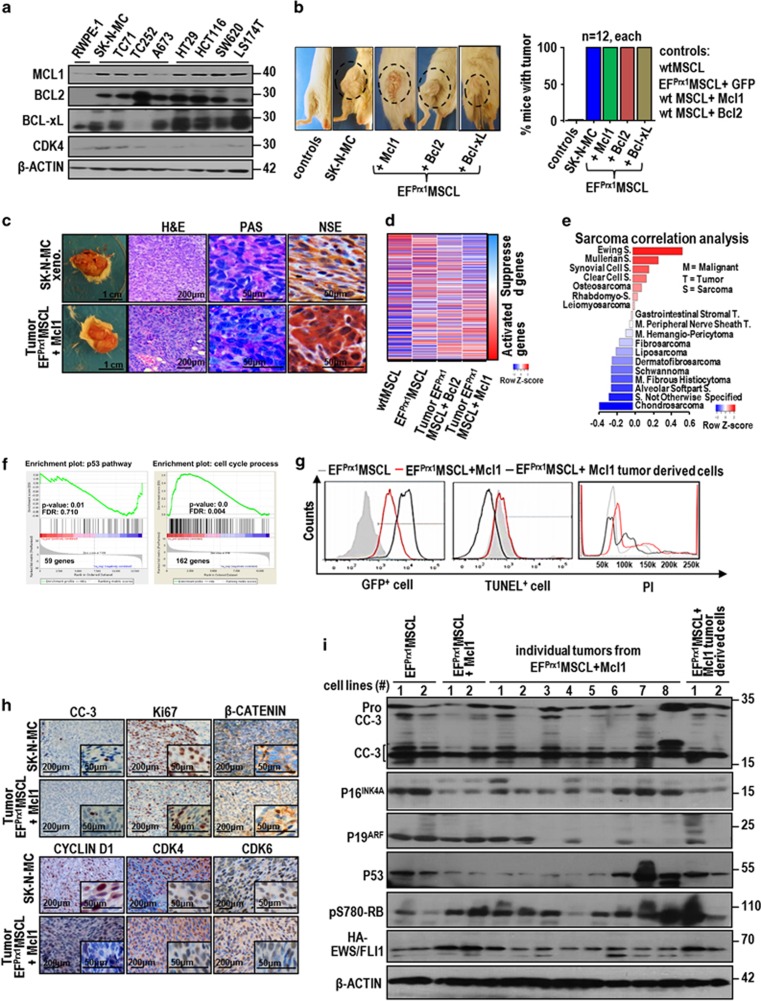
EFPrx1MSCL give rise to sarcomas upon enhanced expression of anti-apoptotic BCL2 family members. (a) ES cell lines SK-N-MC, TC71, TC252 and A673 expressed prominent level of MCL1, BCL2 and BCL-xL. Colorectal carcinoma cell lines HT29, HCT116, SW620 and LS174T were used as positive control. CDK4 expression was higher than in the control human prostate epithelial cell line RWPE-1. (b) Four different EFPrx1MSCL and four different wtMSCL were transduced by retrovirus with either GFP-vector, Bcl2-IRES-eGFP, Bcl-xL-IRES-eGFP or Mcl1-IRES-eGFP. A total of 12 primary cell transductions for each cell line were xenografted (n=12, each). All Bcl2, Bcl-xL and Mcl1-expressing EFPrx1MSCL lines formed reproducibly sarcomas with full penetration as quantified in the right graph. None of the controls like the wtMSCL with or without BCL2 family member transduction or GFP-transduced EFPrx1MSCL formed any sarcoma up to 6 months post transplant. (c) Xenografted sarcomas were positive for periodic acid schiff (PAS) and neuronal-specific enolase (NSE) staining. SK-N-MC xenograft served as positive control. (d) RNA-seq analysis (from left to right) of wtMSCL, EFPrx1MSCL, two sarcoma samples from EFPrx1MSCL+Bcl2 and EFPrx1MSCL+Mcl1 revealed that samples become more similar to the ES gene expression signature (Kauer data set28). (e) Clustering analysis showed the best matching of EFPrx1MSCL+Mcl1 tumor genes to human ES signatures. (f) Gene enrichment analysis (GSEA) exhibited a noticeable upregulation of cell cycle and a downregulation of p53 pathway in mouse EFPrx1MSCL+Mcl1 tumors versus wtMSCL. (g) EFPrx1MSCL at passage 30 served as controls. Two representative sarcoma lines EFPrx1MSCL+Mcl1 were established each that displayed an increase of GFP expression and a decrease in TUNEL+ cells after sarcomas formed, whereas PI staining displayed more proliferation in EFPrx1MSCL+Mcl1 and EFPrx1MSCL+Mcl1 tumor-derived cells. (h) Proliferative sarcoma cells were also positive for nuclear β-catenin, cyclin D1, CDK6 and CDK4, whereas cleaved caspase-3 (CC-3) was downregulated. All shown staining images are a representative of independent IHC analyses of n=12 isolated tumors per group. (i) Western blot of two EFPrx1MSCL, two EFPrx1MSCL+Mcl1, eight EFPrx1MSCL+Mcl1 sarcomas and two EFPrx1MSCL+Mcl1 tumor-derived cells showed an overall reduced level of caspase-3 (Pro CC-3), CC-3, P16Ink4A, P19ARF, P53 and higher amount of pS780-RB protein level upon enforced MCL1 expression in EFPrx1MSCL and associated tumor samples. Representative blots of three independent analyses are shown